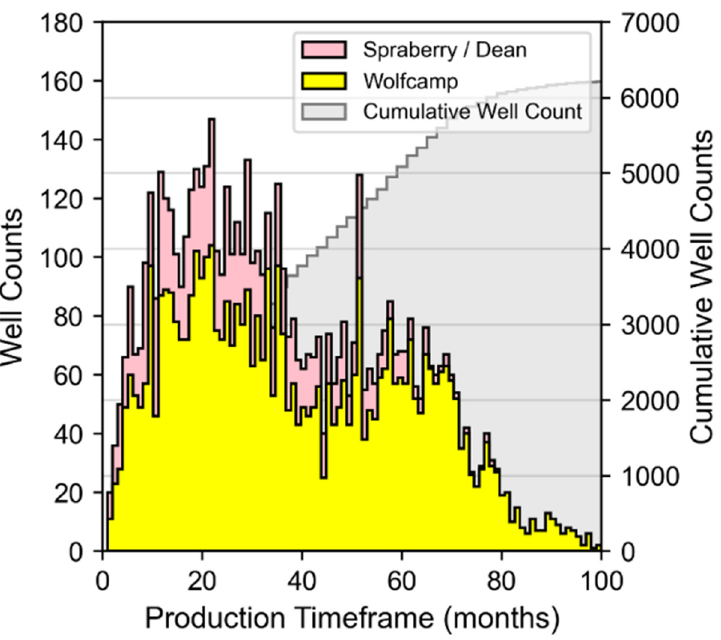
Figure 12. Stacked (left y -axis) and cumulative (right y -axis) histograms of well counts within the study dataset based on the production timeframe for each well.